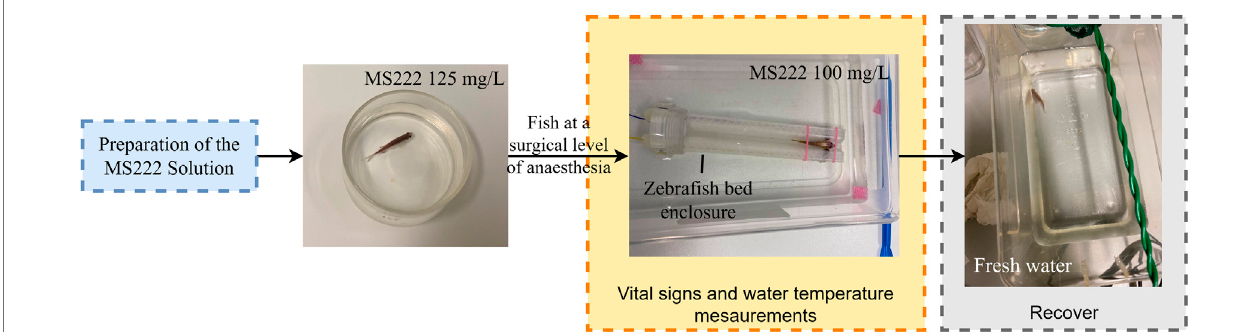
FIGURE 1 | Anesthesia protocol followed in the present work.